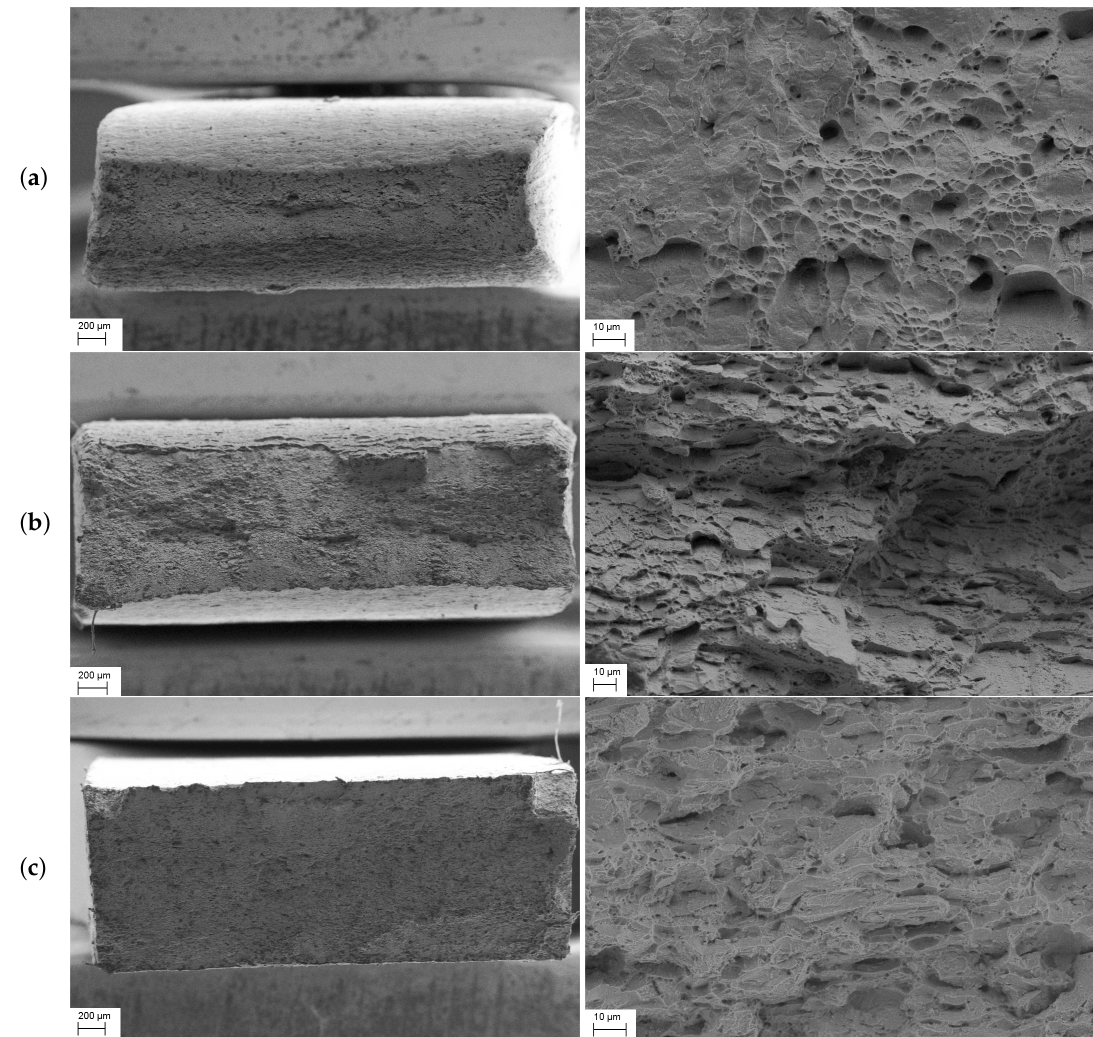
Figure 6. Fracture surfaces for the tensile test specimens with ( a ) 0%, ( b ) 5% and ( c ) 10% σ -phase, tested at room temperature. To the left is the total fracture area and to the right is a close-up of the fracture